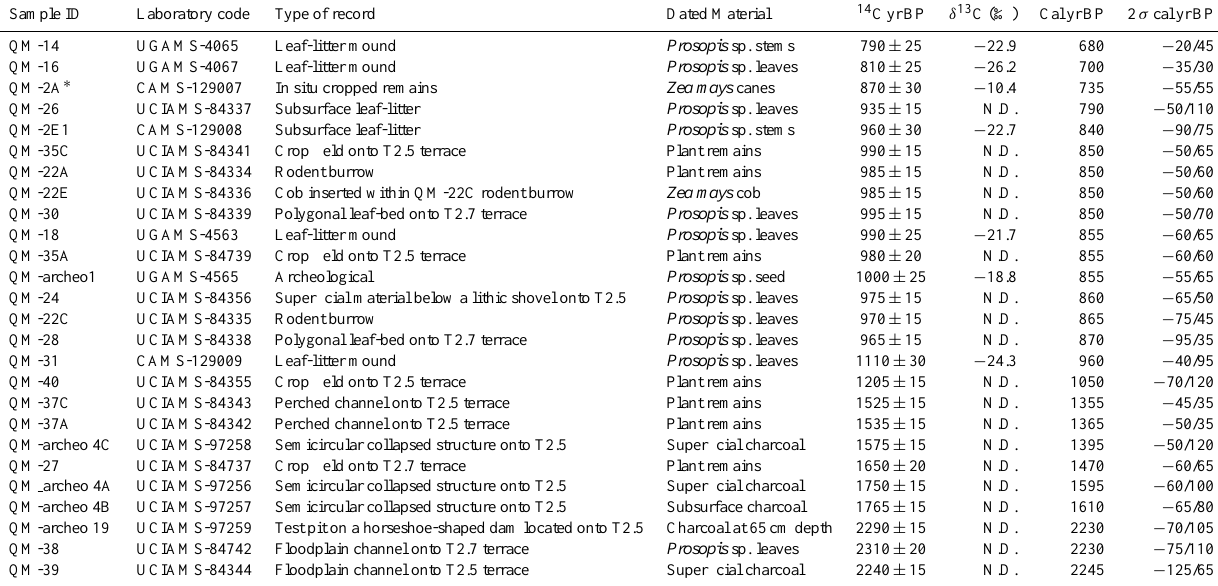
Table 1. AMS dates and depositional context for the 22 records used in this study. Calibrated ages in years BP and corresponding confidence intervals at 2 σ level are illustrated graphically in Fig.